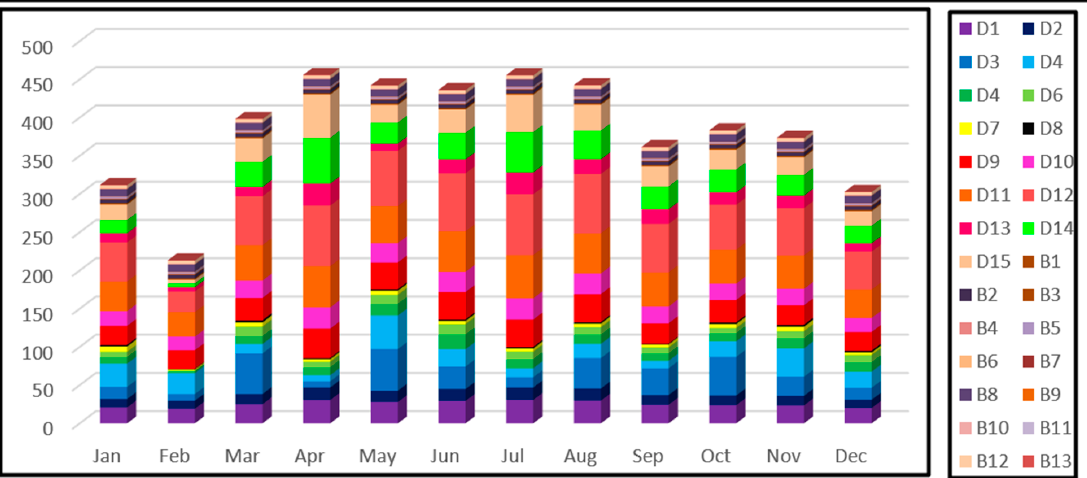
Figure 7. Supply delivered to study area (MCM). Table 8. Monthly water distribution in the study area (MCM).